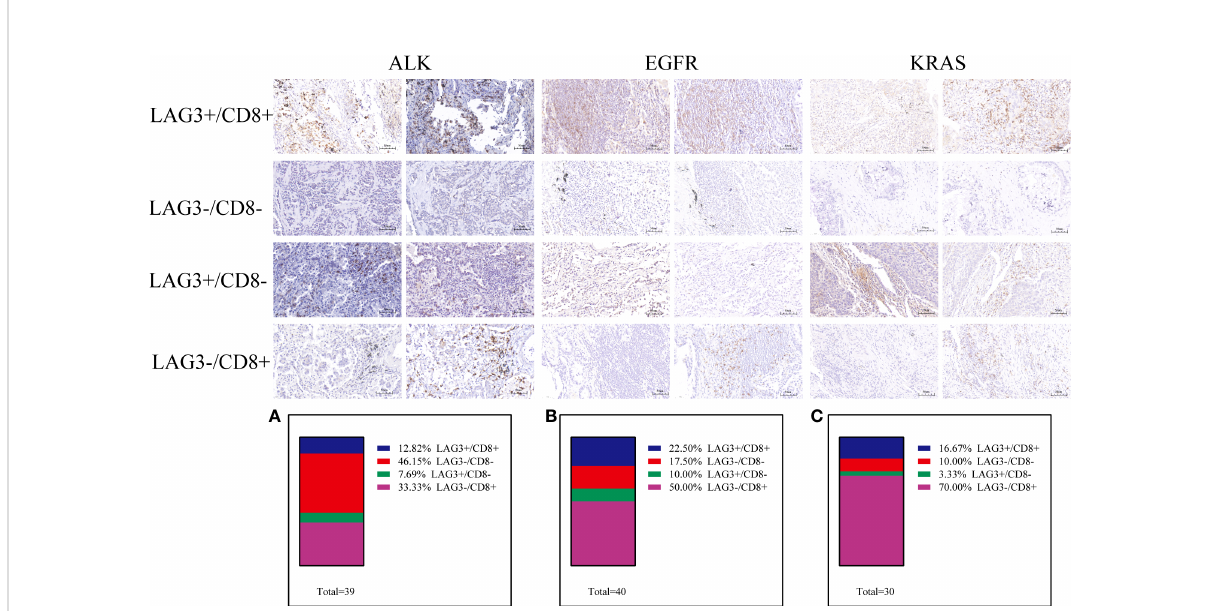
FIGURE 4 Differential proportion of LAG3+/CD8+, LAG3-/CD8-, LAG3+/CD8-and LAG3-/CD8+ in ALK-positive (A) , EGFR-positive (B) and KRAS-positive (C) NSCLC. Low (-) and High (+)